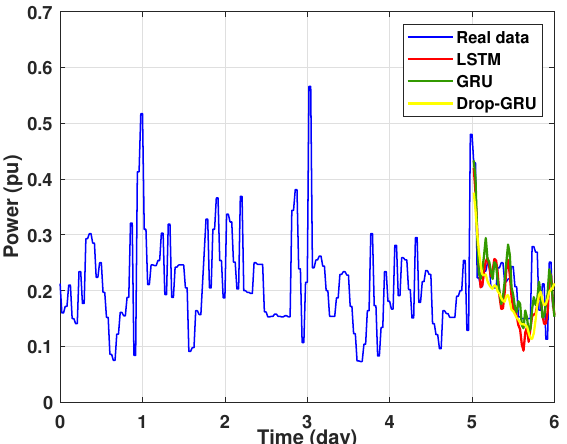
Figure 13. Prediction results of 1 day power